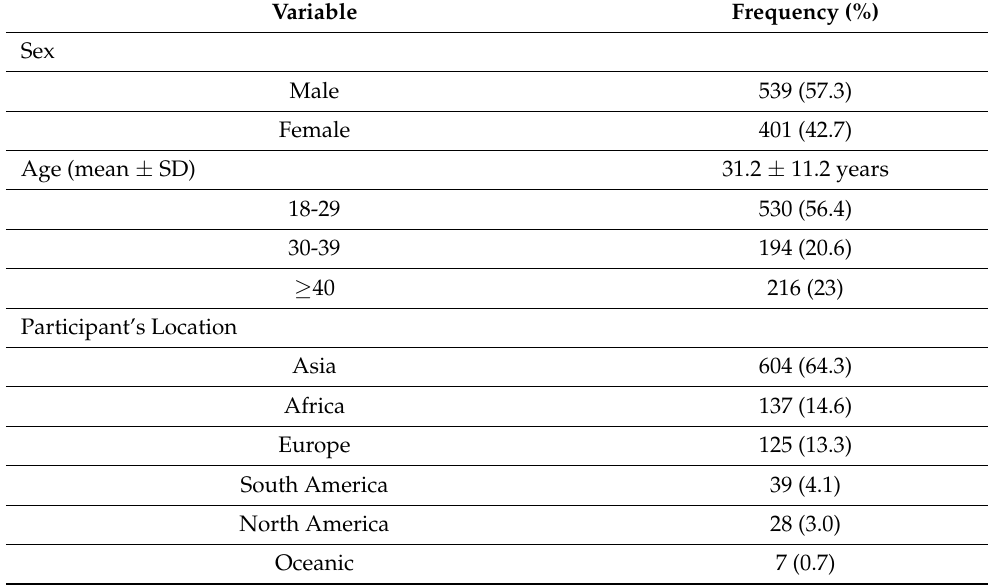
Table 1. Characteristics of study participants (N =